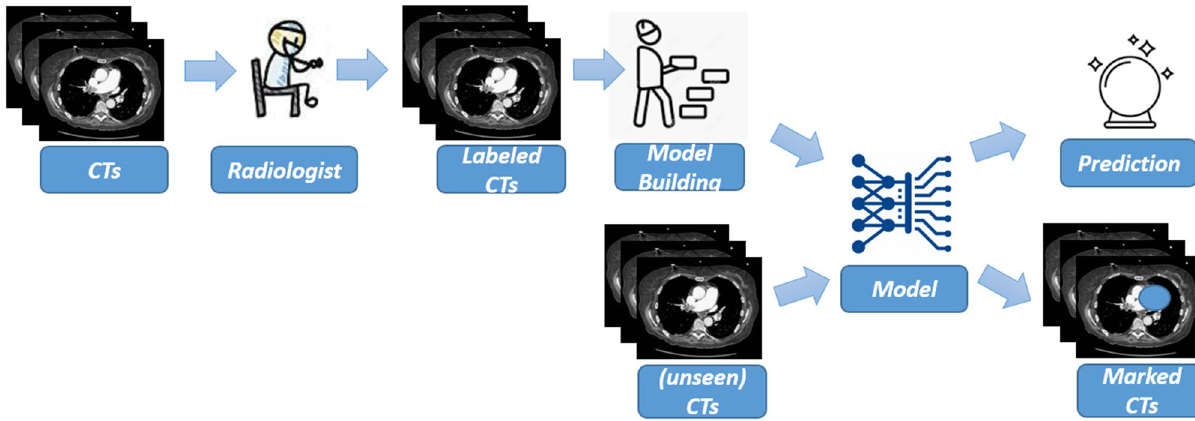
Figure 1. The workflow of the proposed